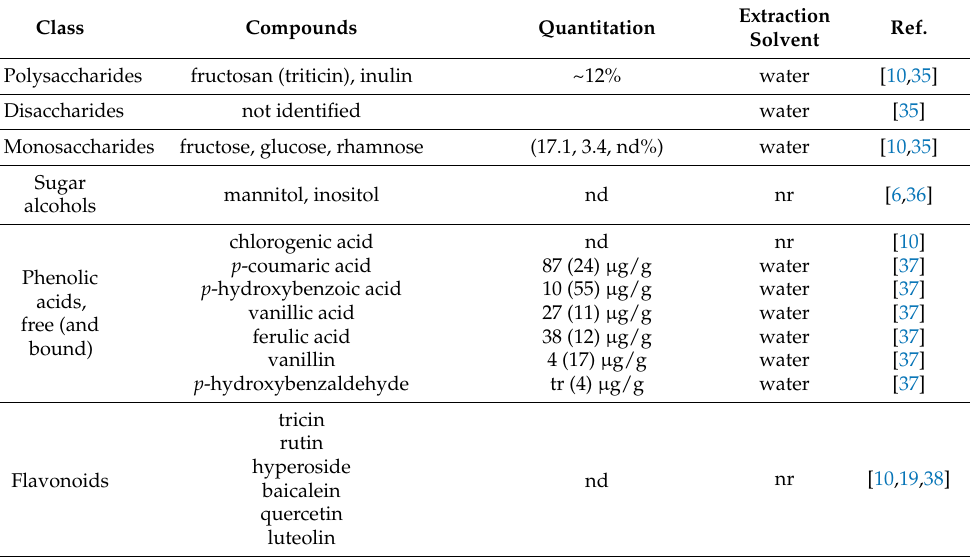
Table 1. Chemical constituents of Agropyron repens rhizome extracts (literature data) [33,34].